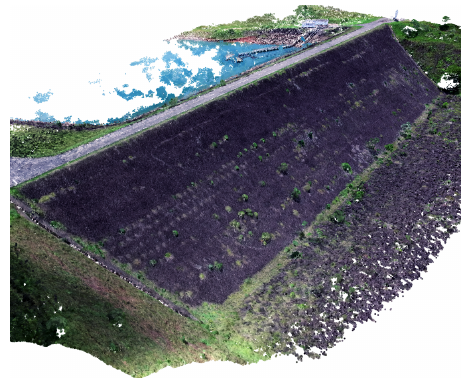
Figure 7. Three-dimensional Structure From Motion (3D SFM) Reconstruction of a Water Dam